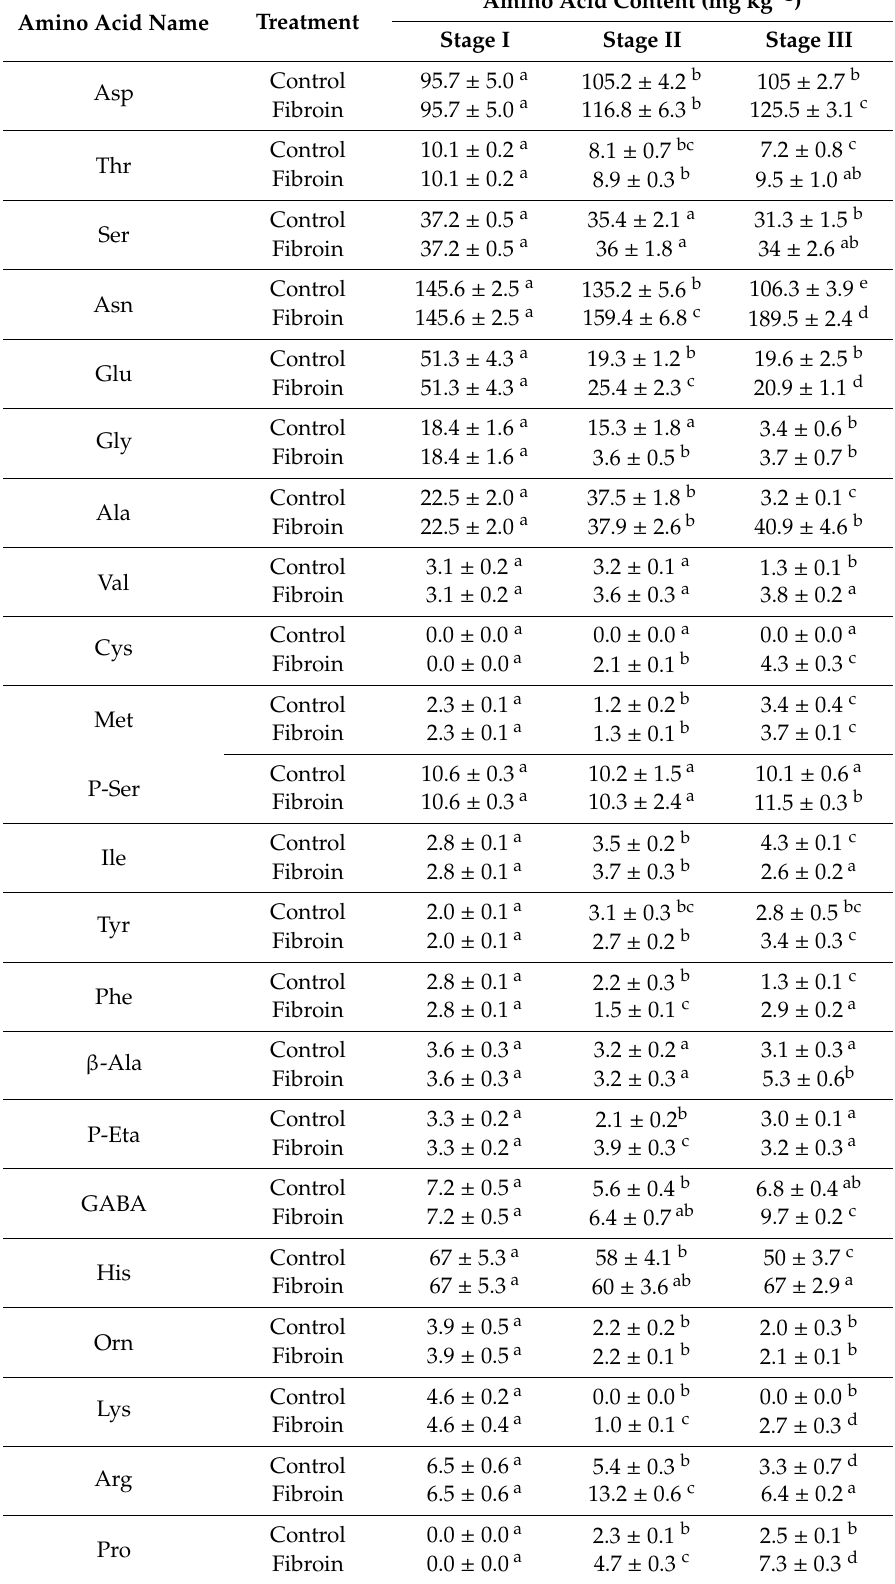
Table 1. Contents of major amino acids in harvested banana fruit during storage. The data are presented as means ± standard errors ( n = 3). The means with di ff erent letters are significantly di ff erent ( p <